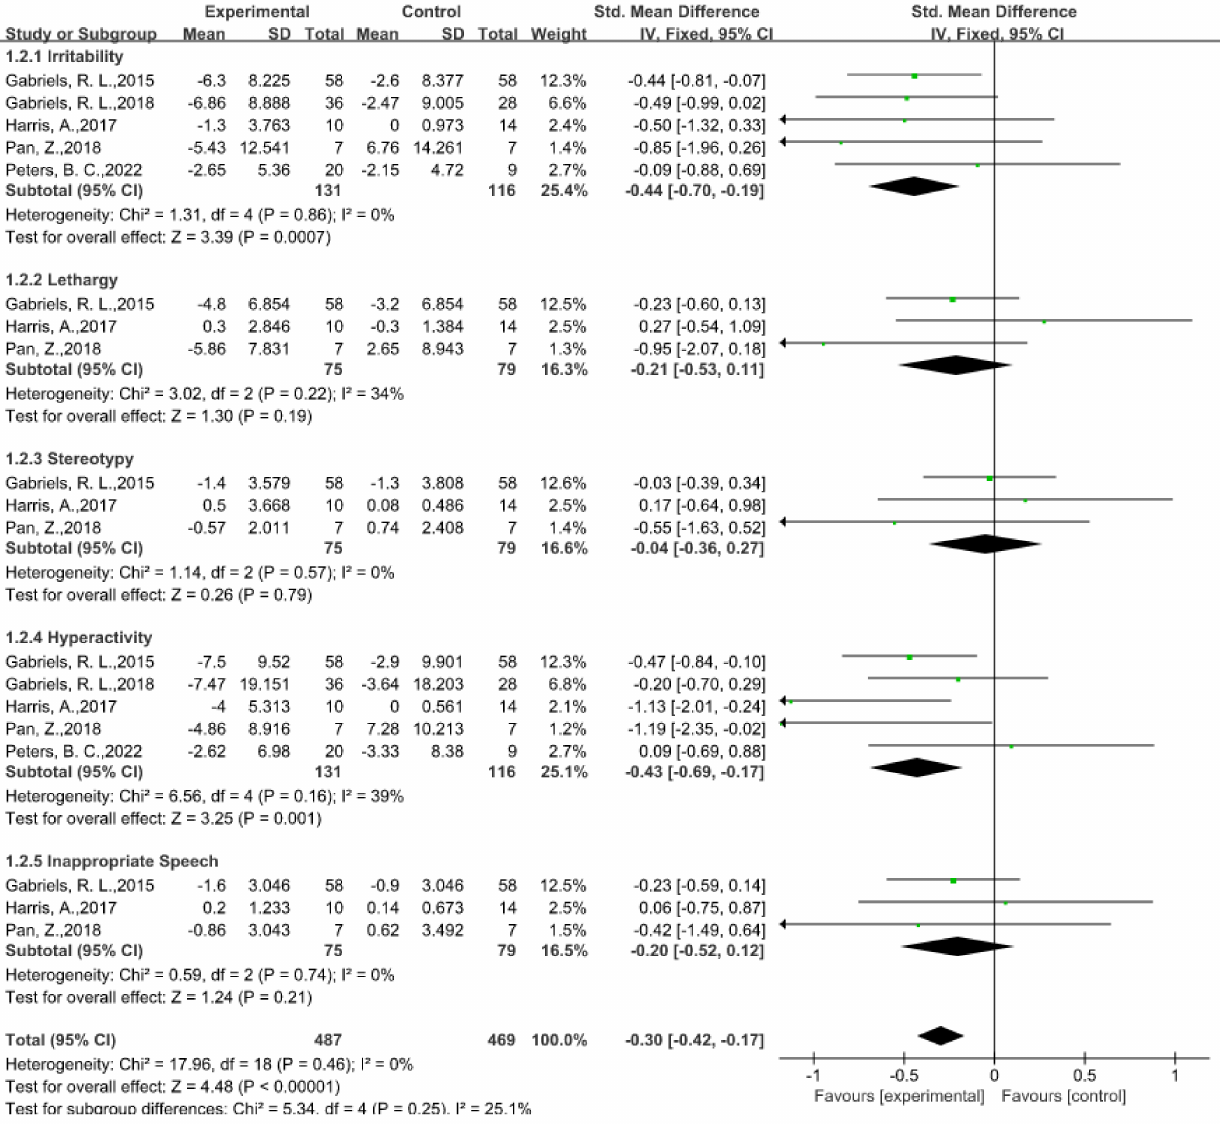
Figure 5. Forest plot of behavioral function using ABC-C [30,43,56,57,59]. The remaining four studies [27,49,61,62] in which the authors used the VABS lacked controlled trials; however, they do report pre- and post-trial data. We also used the fixed- effects model with 95% confidence intervals that the participants’ behavioral competency would substantially increase following the EAAT programs (SMD = 0.22, 95% CI [0.09, 0.35], p = 0.0008) (see Figure 6 for details). Participants also demonstrated appreciable improve- ments in the socialization subdomain following EAATs (SMD = 0.27, 95% CI [0.03, 0.52], p = 0.03). However, the data do not indicate any appreciable improvement for the other three domains: communication (SMD = 0.18, 95% CI [ − 0.06, 0.43], p = 0.15); daily liv- ing skills (SMD = 0.20, 95% CI [ − 0.06, 0.46], p = 0.13); adaptive behavior (SMD = 0.24, 95% CI [ − 0.06, 0.54], p =